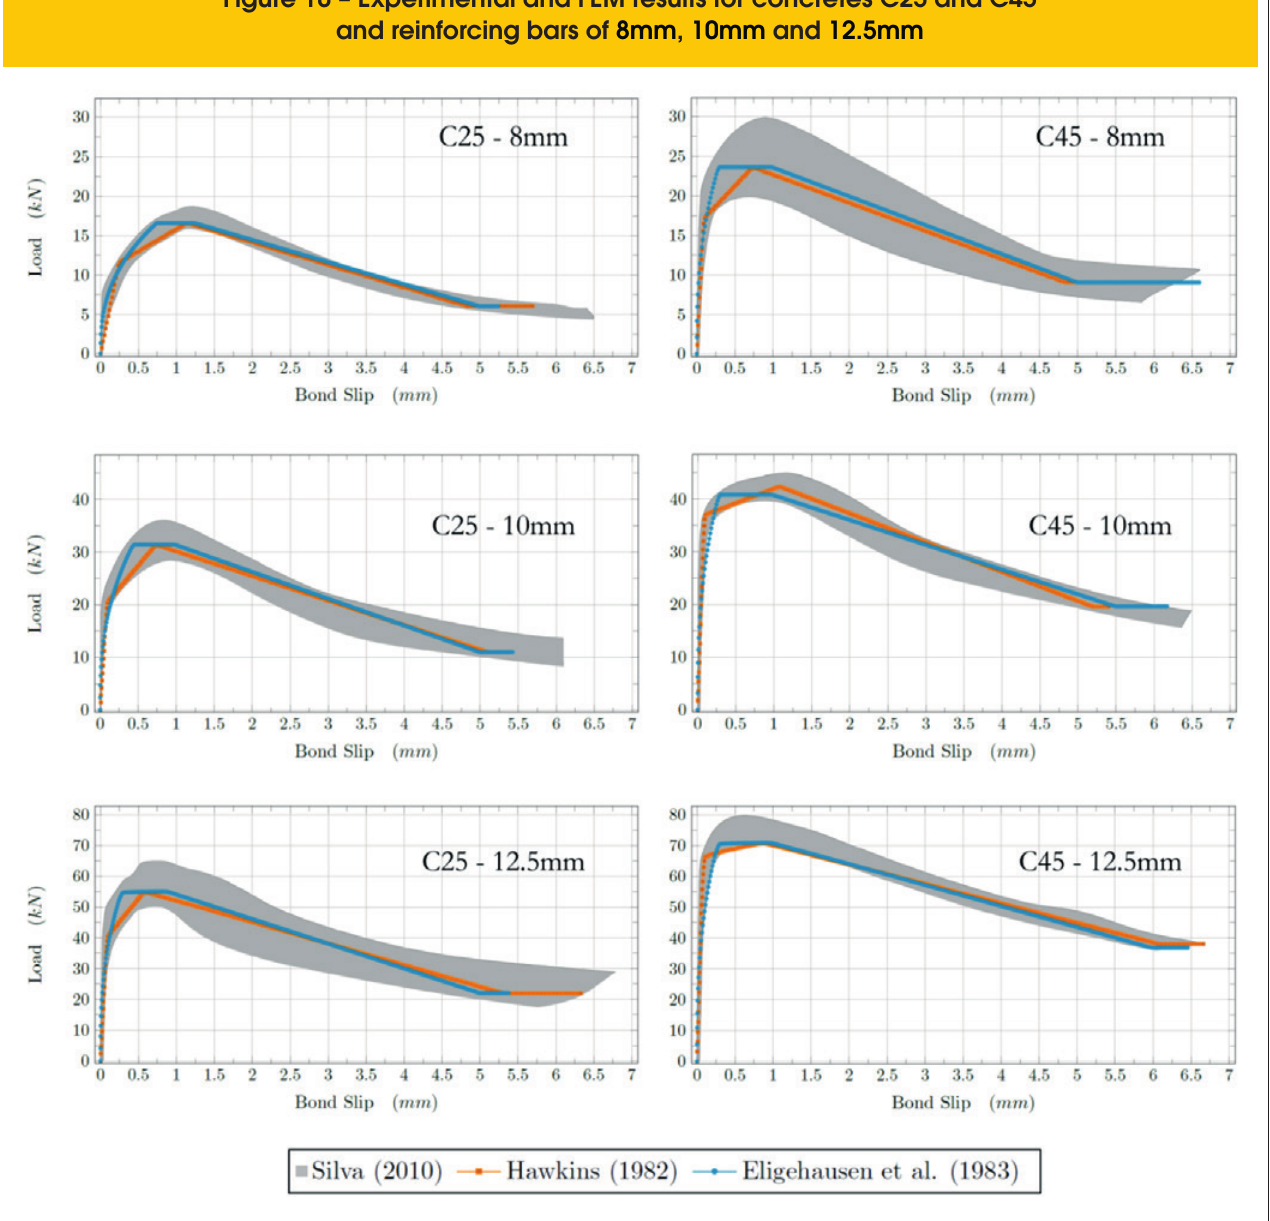
Figure 10 – Experimental and FEM results for concretes C25 and